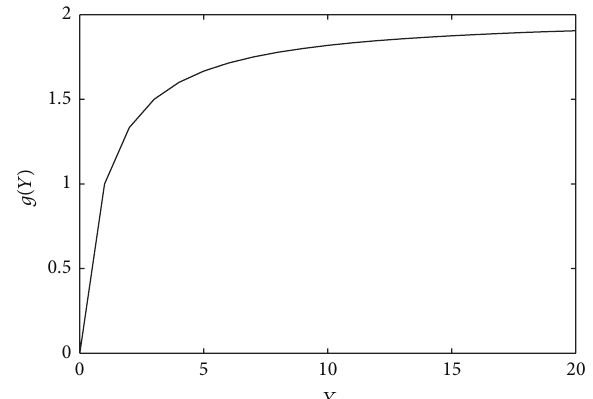
Figure 1: Plot of 𝑔(𝑌) as a function of 𝑌 with 𝑎 = 2 and 𝑏 = 1 (color